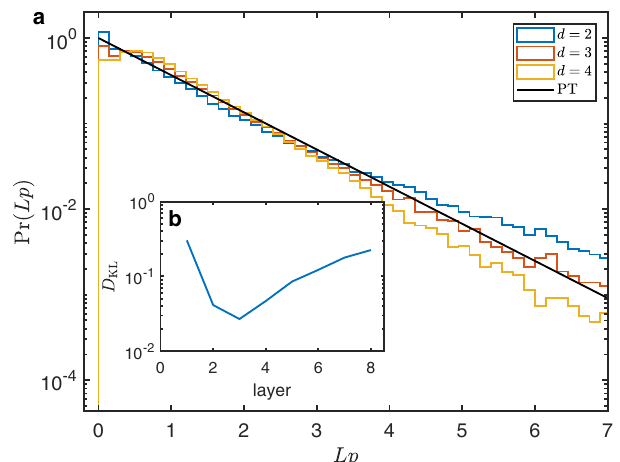
Fig. 4 | Histograms of output bit-string probabilities sampling from pseudo- random circuits for nine qubits and KL divergence. a Three histograms are sampled from two, three and four layers of circuits. Dark solid line represents the PTdistribution. b TheKLdivergencebetweenthesamplingdistributionandthePT distribution over